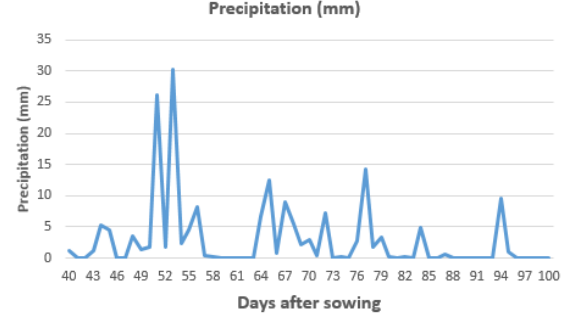
Figure 2. Daily precipitation (mm) between 40 days after sowing to 101 days after sowing